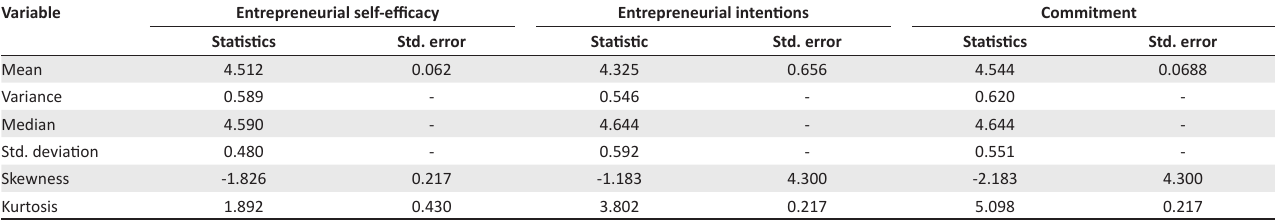
Table 2 is a summary of two-level factor analysis with respective factor loadings for the three constructs of self- efficacy, entrepreneurial intentions and commitment. Factors